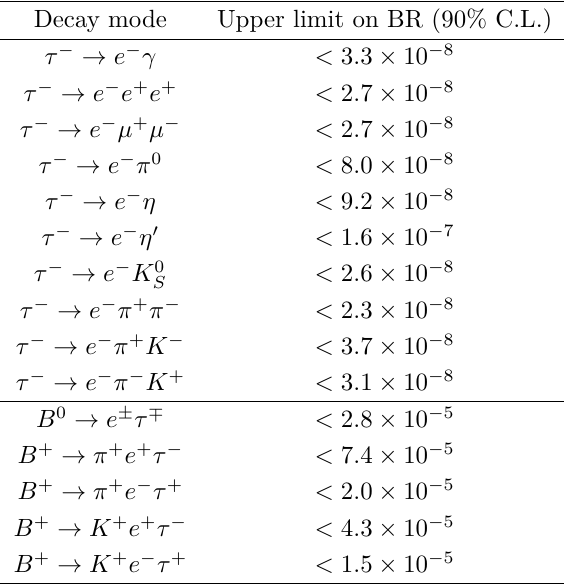
Table 9 . Summary of the low-energy decay modes and current experimental limits on their branch- ing ratios [57].